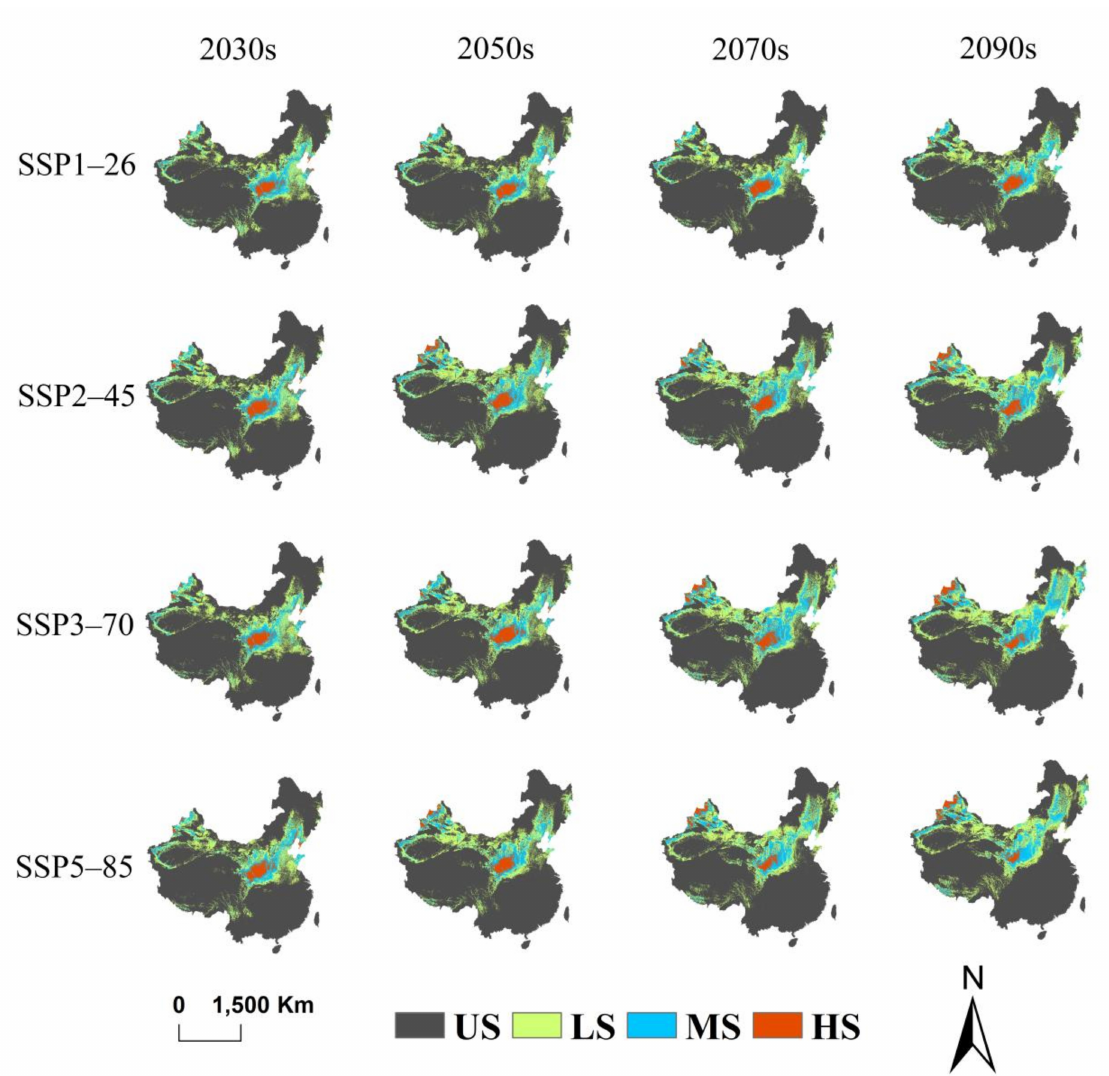
Figure 3. Distribution maps of Valsa mali in di ff erent climate scenarios and periods (2030s, 2050s, 2070s, and 2090s) of the 21st century. The Shared Socioeconomic Pathways (SSPs) 1–26, SSP2–45, SSP3–70, and SSP5–85 represent four climate scenarios. The US, LS, MS, and HS represent the suitability of unsuitable, low suitable, moderately suitable, and highly suitable,